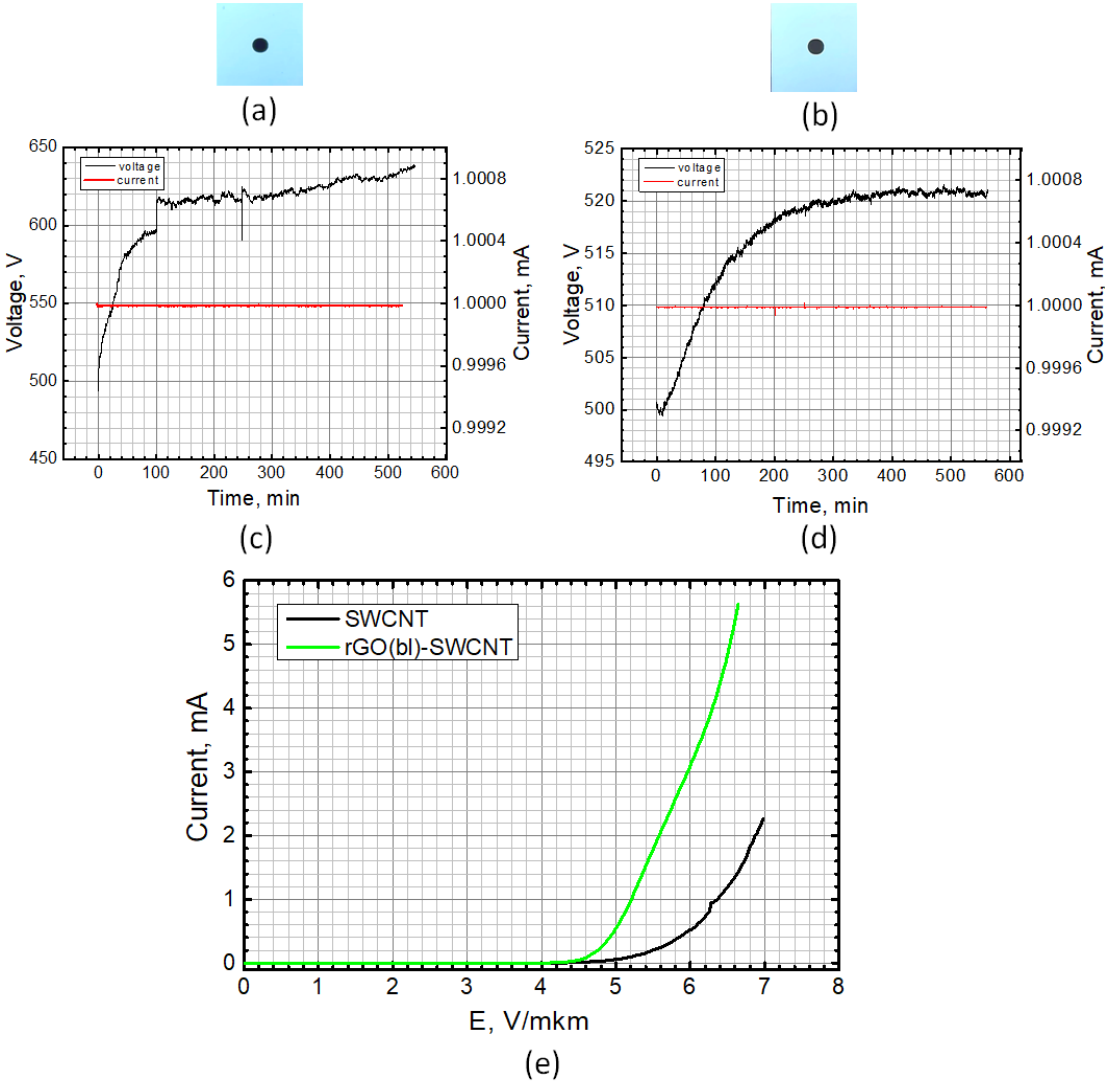
Figure 13. External view of a field emission cathode based on: ( a ) SWCNT and ( b ) rGO(bl)-SWCNT hybrid nanostructures, corresponding to the voltage–time characteristic at a constant emission current of 1 mA for ( c ) SWCNT and ( d ) rGO(bl)-SWCNT cathodes; ( e ) Current–voltage characteristics for SWCNT (black line) and rGO(bl)-SWCNT (green line) cathodes.